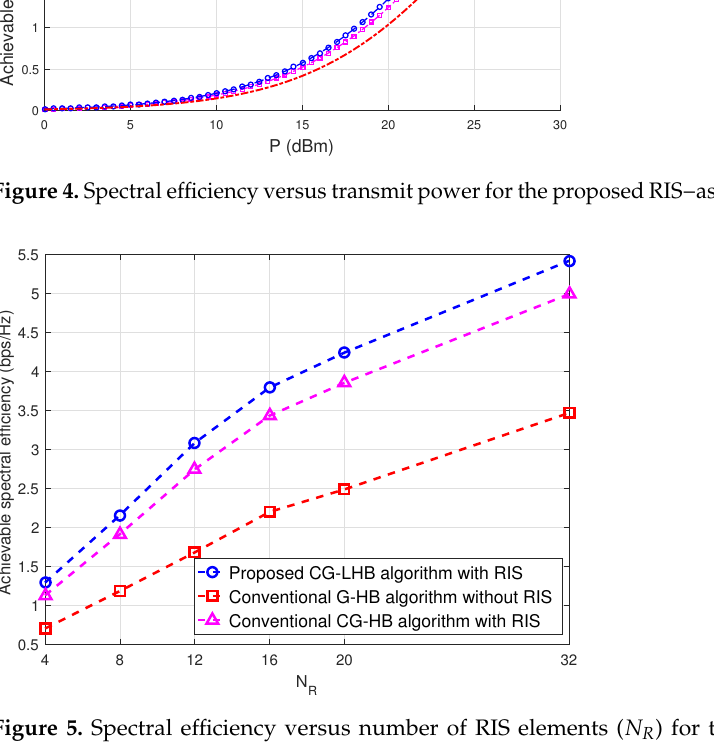
Figure 5. Spectral efficiency versus number of RIS elements ( N R ) for the proposed RIS-assisted CG−LHB